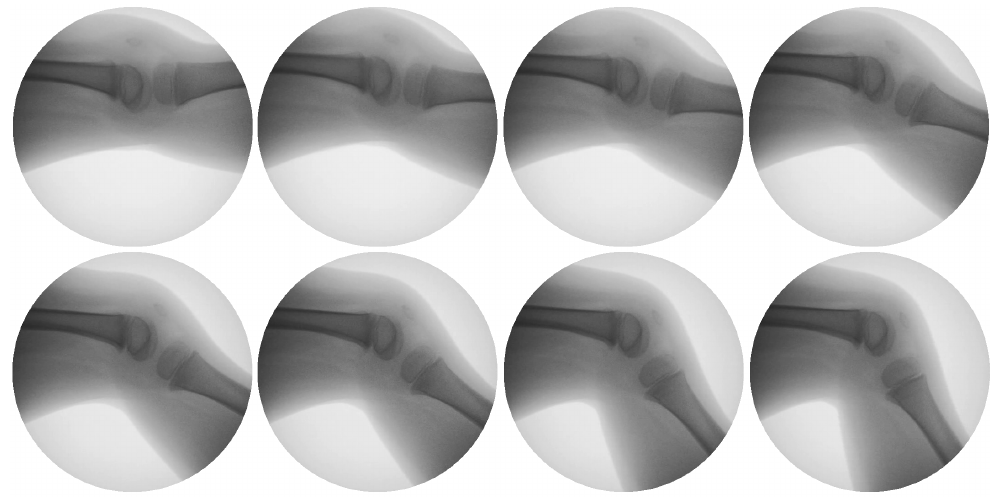
Figure 3. Example image frames of one subject. Images were adjusted for visualization